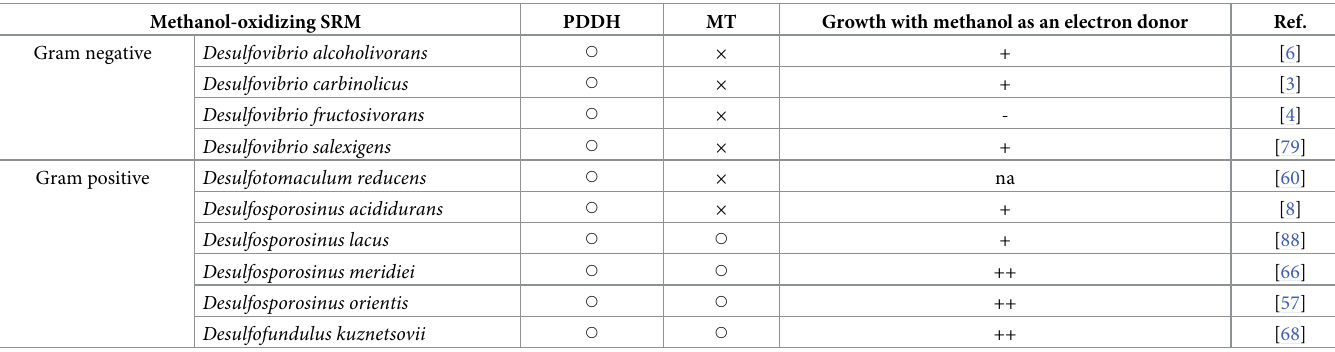
Table 3. Presence of methanol dissimilating enzyme homologs in SRMs capable of methanol oxidation and their growth properties. Methanol-oxidizing SRM PDDH MT Growth with methanol as an electron donor